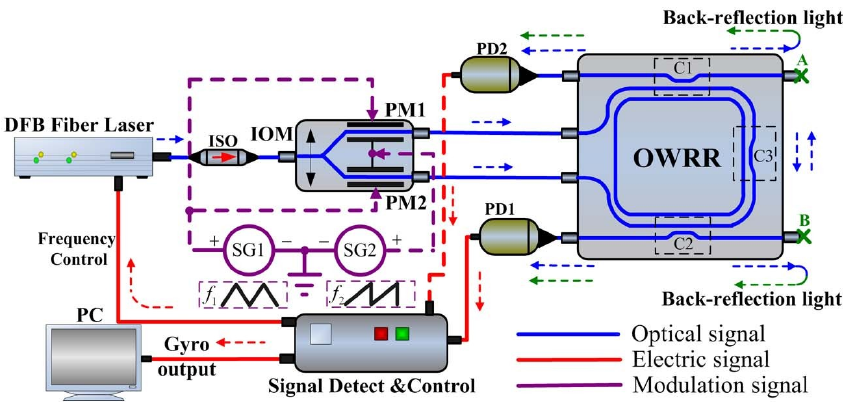
Figure 7. Schematic illustration of the RIOG with two facet-reflection dots. OWRR: optical waveguide ring resonator. Reprinted with permission from ref. [24]. Copyright 2013 The Optical